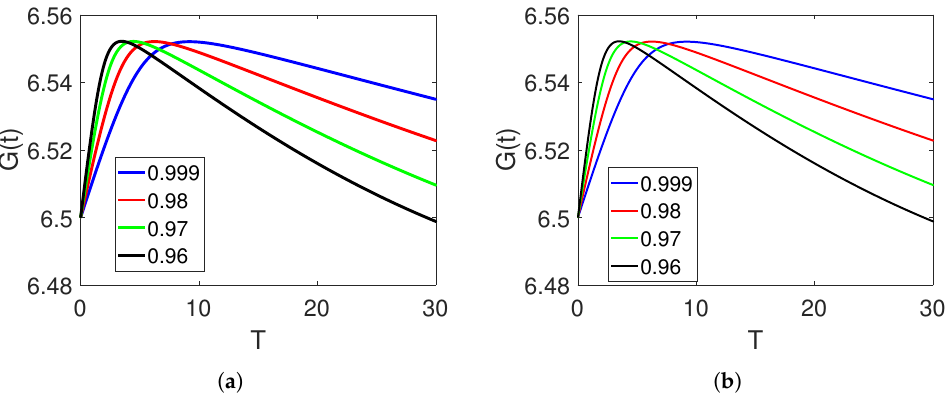
Figure 18. Comparison of Newton polynomial ( a ) and LADM ( b ) for sixth class on different arbitrary fractional